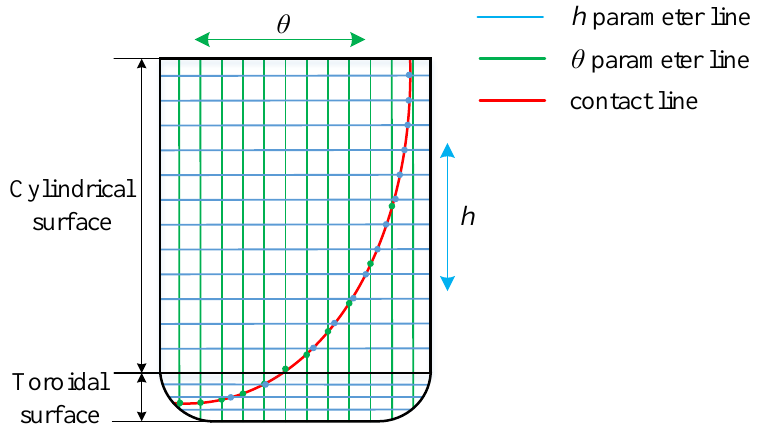
Figure 8. Calculation of contact line.